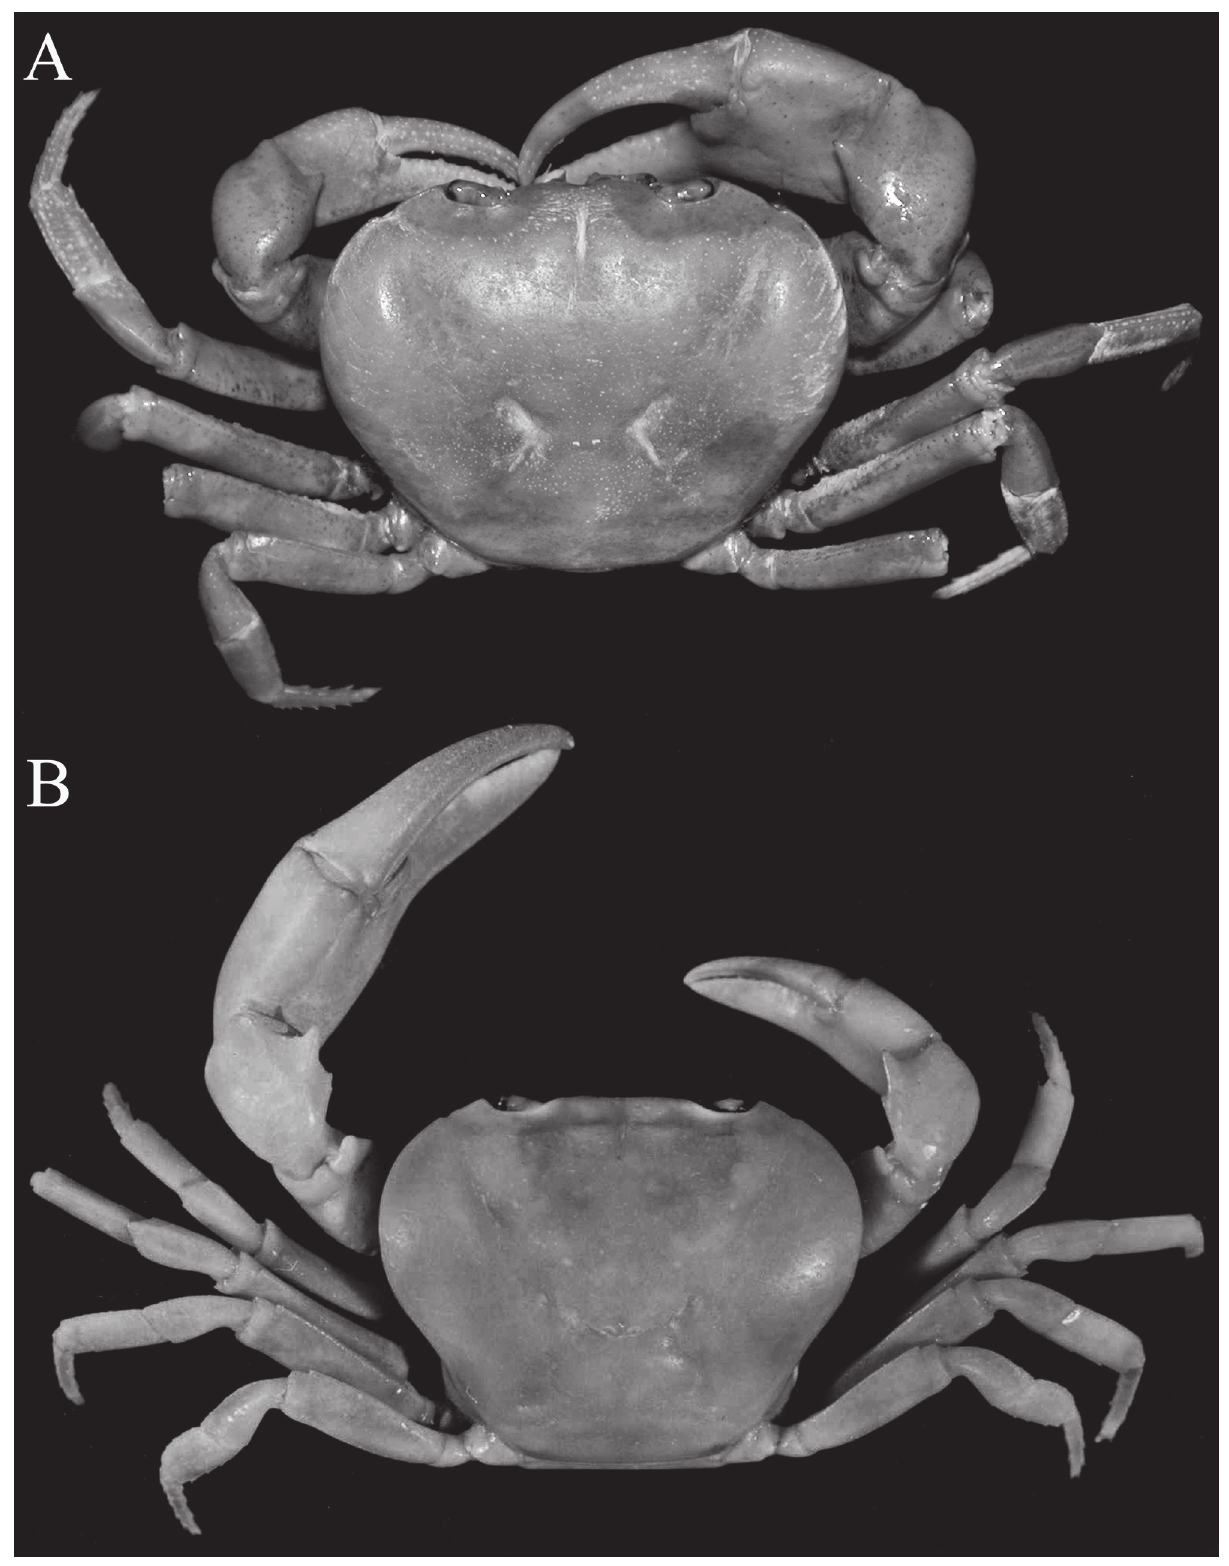
Figure 2. A, Sundathelphusa tuerkayi , new species, holotype, male (34.7 × 26.5 mm) (SMF 1799a), Lombok, Indonesia. B, Sundathelphusa aruana (Roux, 1911), paralectotype, male (27.9 × 21.5 mm) (NMB 695a), Aru Islands,